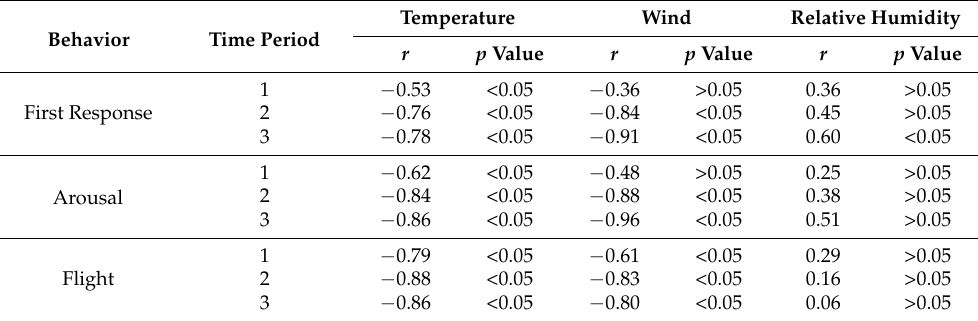
Table 1. Correlation coefficients ( r ) and associated p values of latency to behaviors vs. ambient weather parameters. Values are for each time period: 1 = night before burn trial (2200) to one min before sunrise, 2 = sunrise to one min before onset of trial, 3 = onset of burn trial to end of burn trial. For first response (i.e., movement or increased respiration) and arousal, n = 15 (except time period 1 wind speed ( n = 14)). For flight, n = 17 (except time period 1 wind speed ( n = 16)).